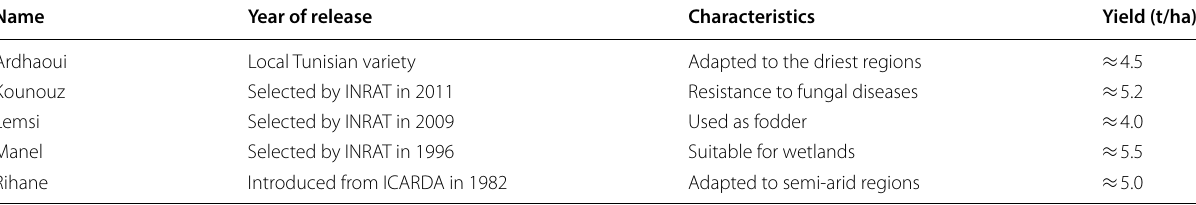
Table 1 Names, year of release and characteristics of the barley genotypes studied (Chaabane et al. 2009; Ben Ghanem and El Felah 2011; Ben Youssef et al.